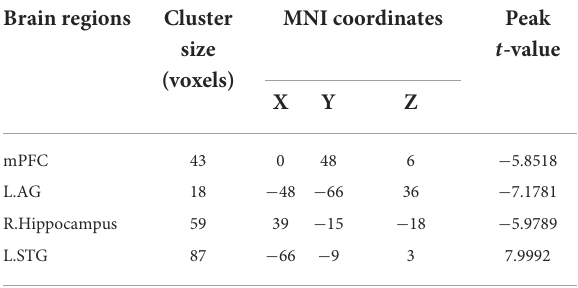
TABLE 3 Stability difference of awake vs. dexmedetomidine sedation